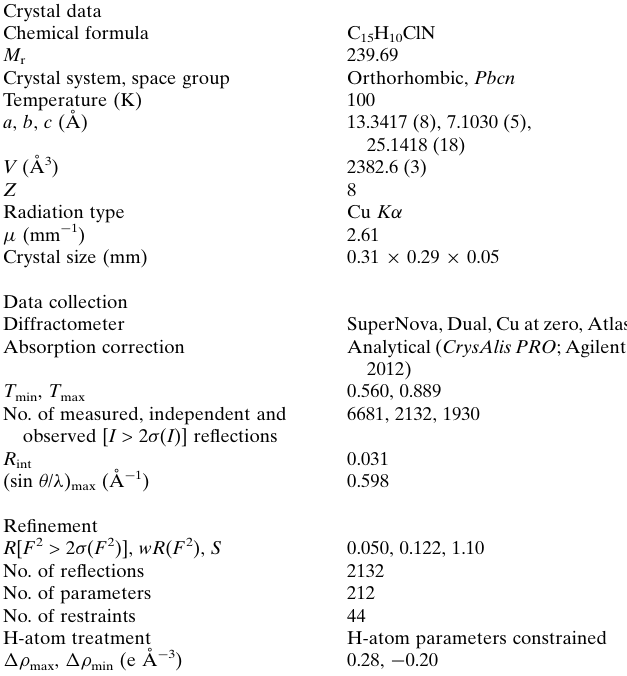
Table 3 Experimental